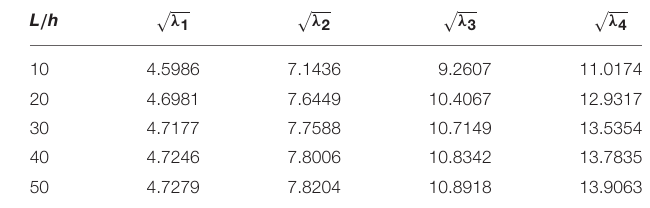
TABLE 19 | Frequency parameters length-to-height ratio.